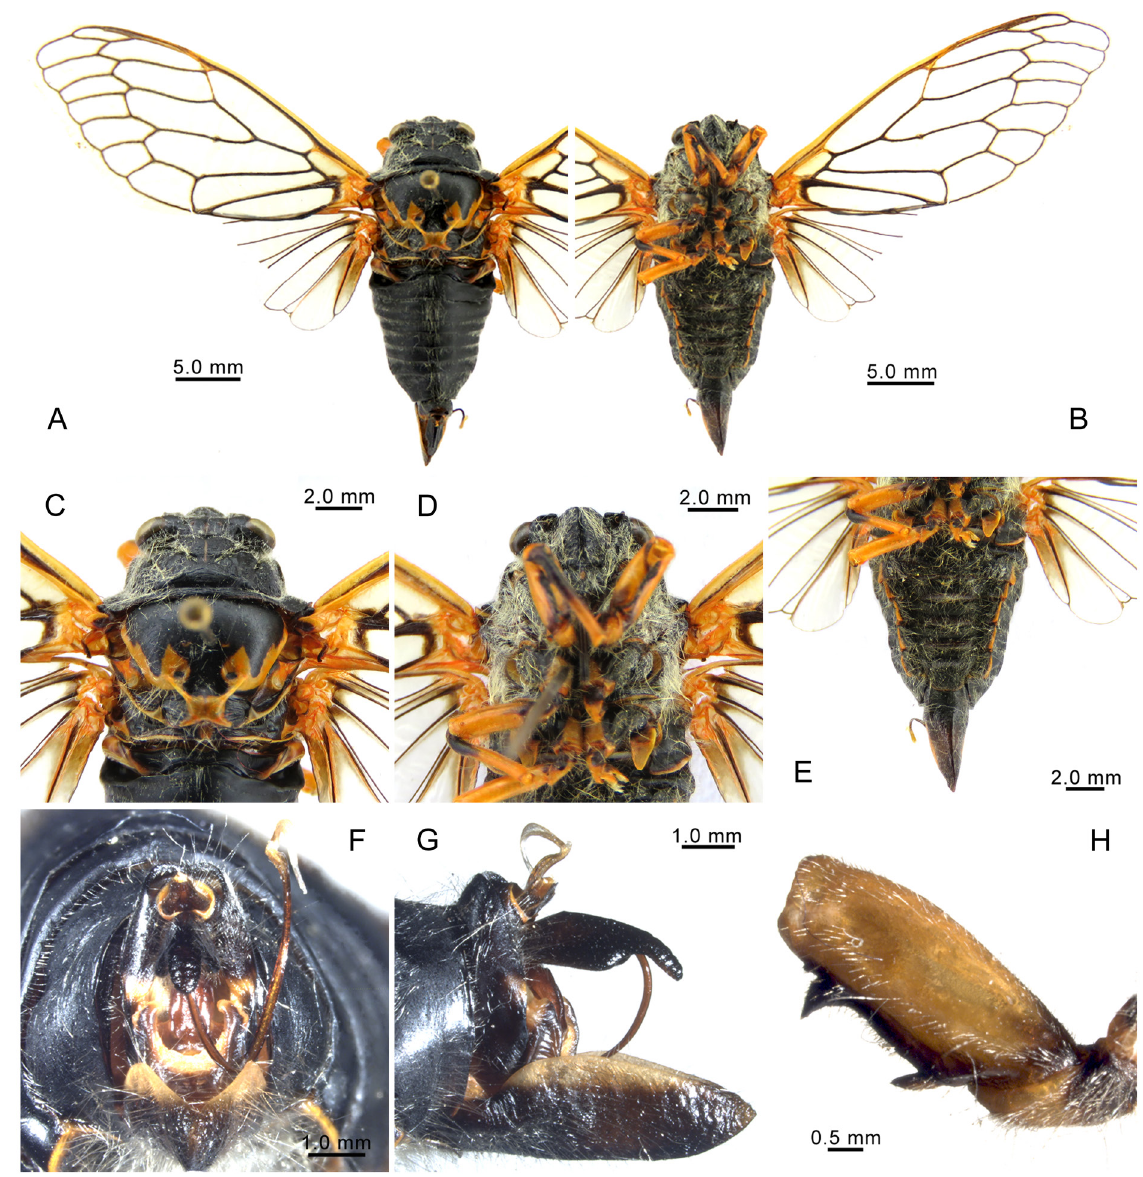
Fig. 3. Paharia putoni (Distant, 1892) (♂, adult), Turkey, Van, Kurubas Geçidi. A . Habitus, dorsal view. B . Habitus, ventral view. C . Head and thorax, dorsal view. D . Head and thorax, ventral view. E . Abdomen, ventral view. F . Pygofer, ventral view. G . Pygofer, lateral view. H . Left fore leg, showing the spines on fore